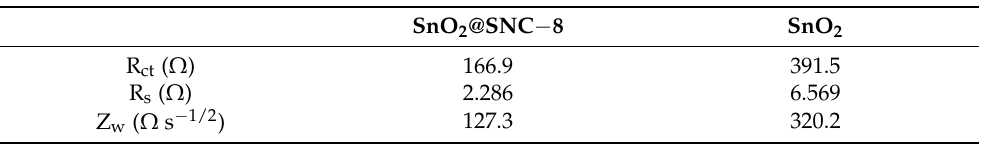
Figure 5. Long cyclic performance at 2 A g − 1 for the ( a ) SnO 2 @SNC − 8 and ( b ) pure SnO 2 . CV curves at a scan rate of 0.1 mV s − 1 in the first three cycles for the ( c ) SnO 2 @SNC − 8 and ( d ) pure SnO 2 . Galvanostatic charge/discharge voltage profiles at 2 A g − 1 for the ( e ) SnO 2 @SNC − 8 and ( f ) pure SnO 2 . ( g ) The charge capacity from the process of conversion reaction and alloyed reaction at the 5th, 10th, 20th and 50th cycle for SnO 2 @SNC − 8 and SnO 2 . ( h ) EIS comparison for SnO 2 @SNC − 8 and SnO 2 sample and the corresponding equivalent circuit model. Table 1. The fitted results of solution resistance (R s ), the charge transfer resistance (R ct ) and Warburg impedance (Z w ) for SnO 2 @SNC − 8 and SnO 2